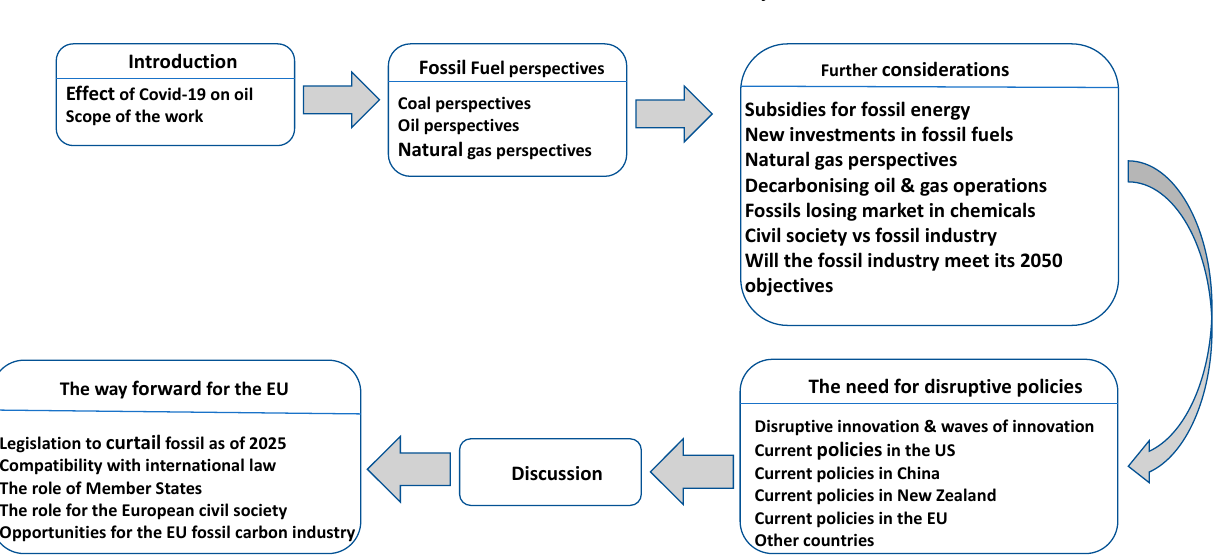
Figure 7. Summary of the methodology.